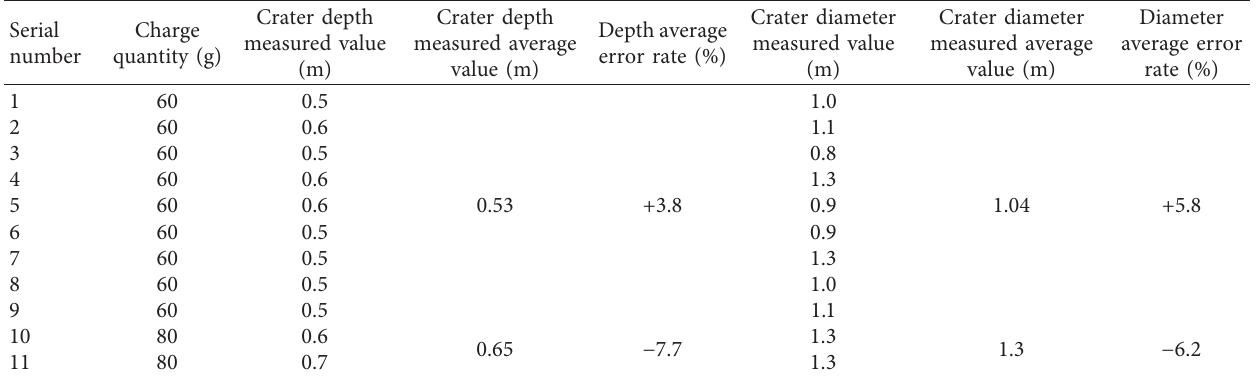
Table 6: Error of field test and numerical simulation.